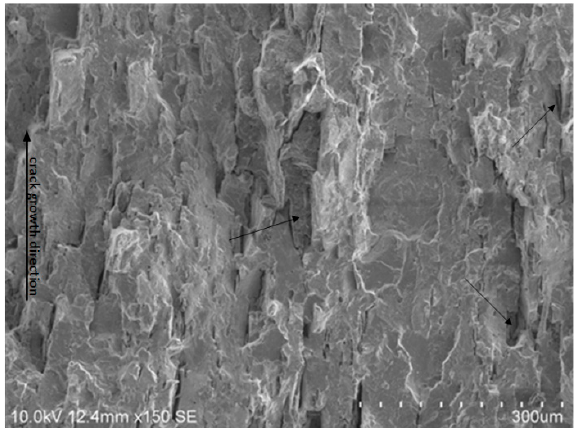
Figure 12. Representative fatigue fracture surface of the broken specimen tested under mode I condition (R = 0.05)—initial fatigue crack growth phase.